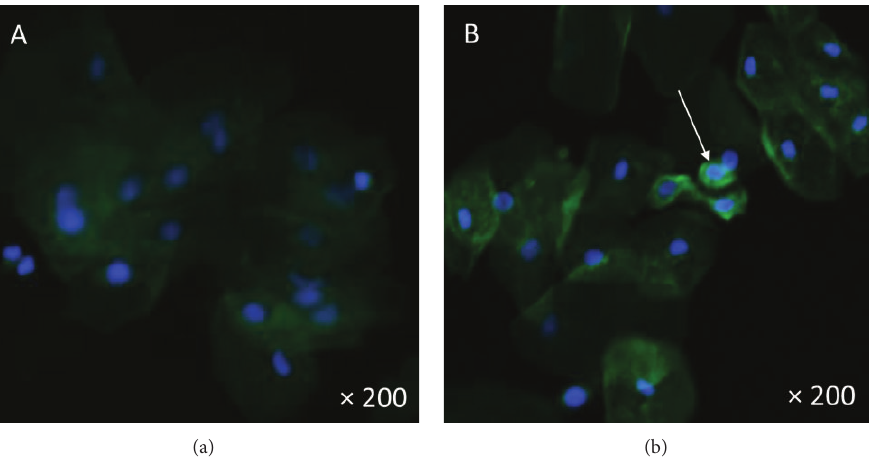
Figure 1: (a) Urine specimen from a control. Tubular cells are observed. No podocytes were identified. (b) The arrow indicates the presence of podocytes, as bright green fluorescent cells. Fluorescent microscopy ×